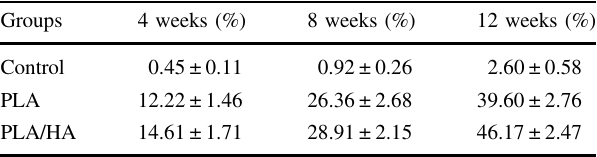
Table. 3 The quantitative evaluation of newly formed bone area percentage in each group by immunohistochemical staining